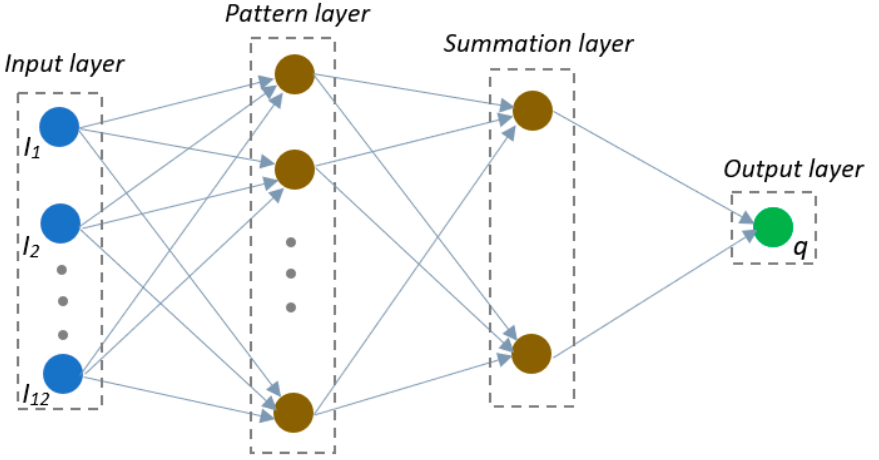
Figure 2. Schematic diagram of a GRNN.